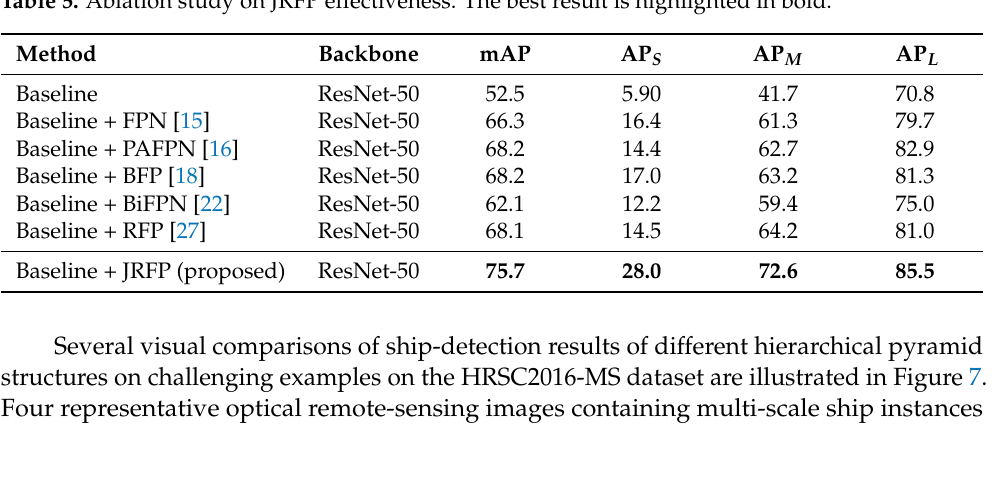
Table 5. Ablation study on JRFP effectiveness. The best result is highlighted in